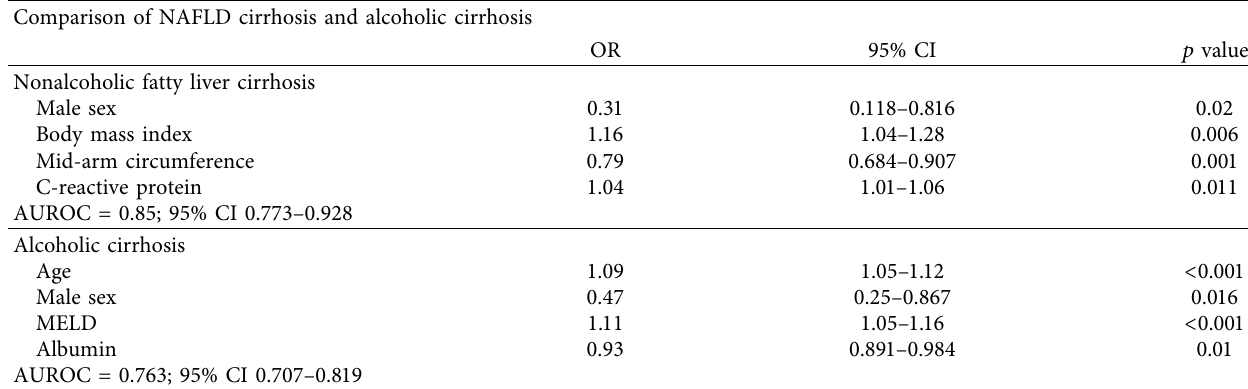
Table 3: Predictive factors of frailty defined by the liver frailty index > 4.5, a multivariate logistic model.